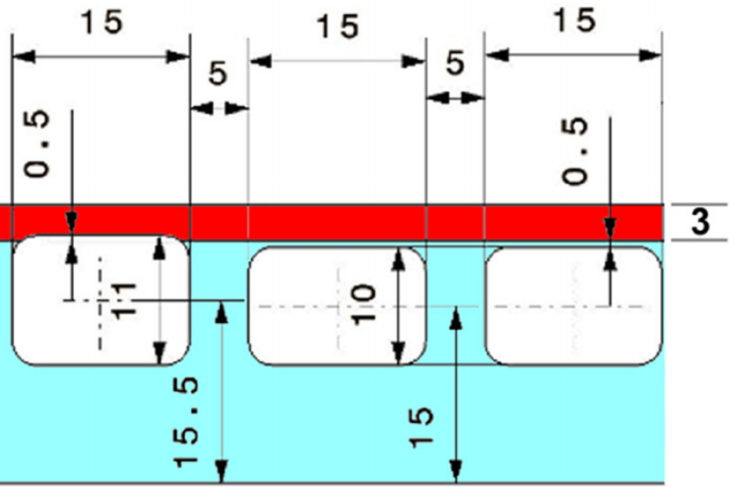
Figure 31. Dimensions of the mock-up plate and geometry of the cooling channels. The cooling channel cross-sections are 10 mm (height) by 15 mm (width) with a 2 mm radius at the corners. The channel in the middle (the left one in the drawing) is higher by one millimeter compared to the other four. That is, this channel exceeds the baseplate of EUROFER97/2 (cyan) and is machined into the ODS steel plating (red). Therefore, the diffusion bond-lines run along both upper corners. This means that we have placed the potentially weakest points (the weld seam) in the area of highest stress (this is due to stress concentration along the 2 mm radii of the